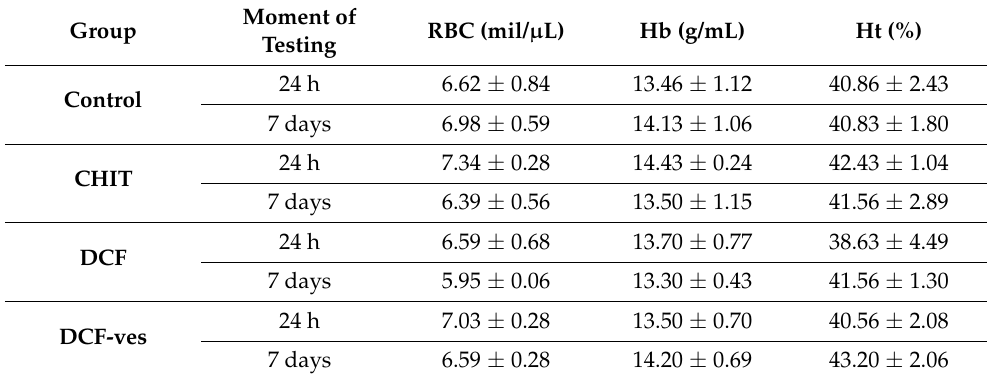
Table 3. Serum levels of RBC, Hb and Ht in rats treated with CHIT, DCF and DCF-ves. The data are expressed as arithmetic mean ± S.D. of the average values for 6 animals per group.